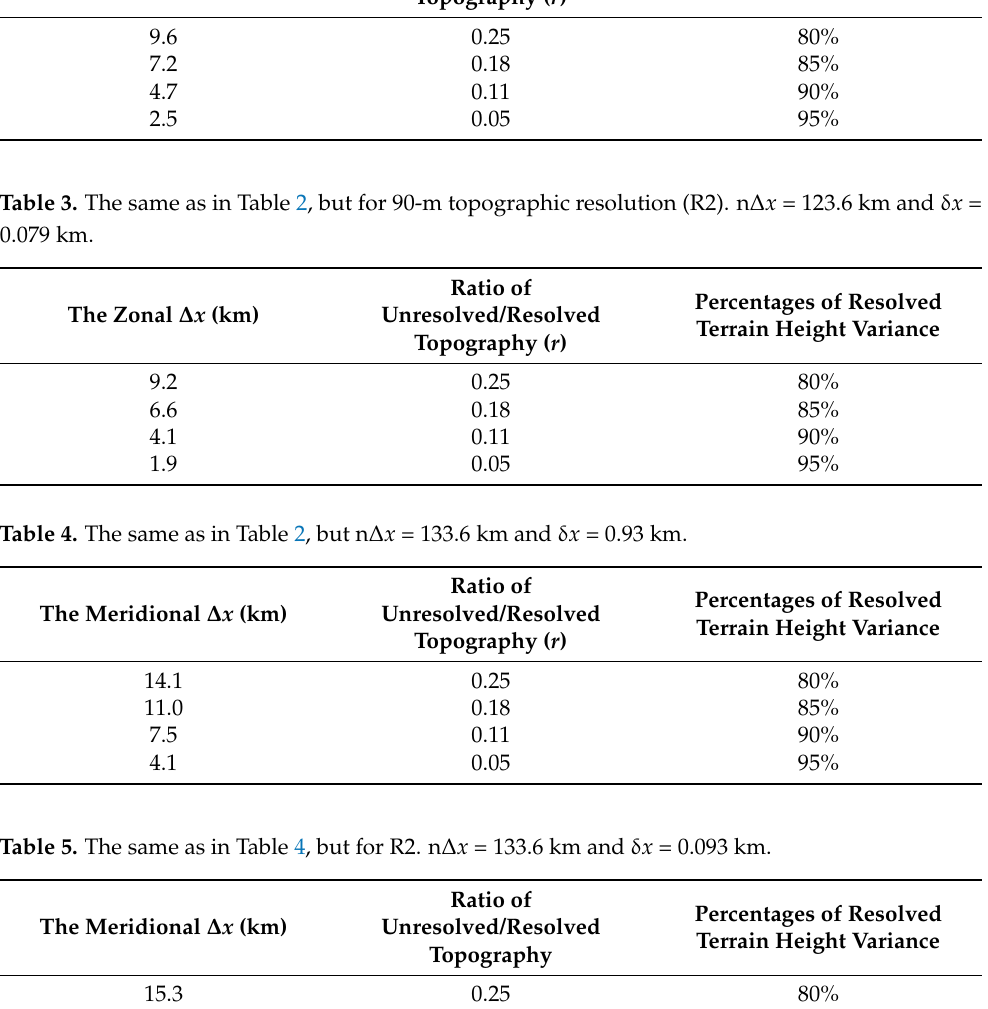
Table 2. The resolved terrain height variance of R1 for model resolution and the ratios of unre- solved/resolved topography ( r ) in mesoscale model. n ∆ x = 123.6 km and δ x = 0.793 km. Ratio of The Zonal ∆ x (km)